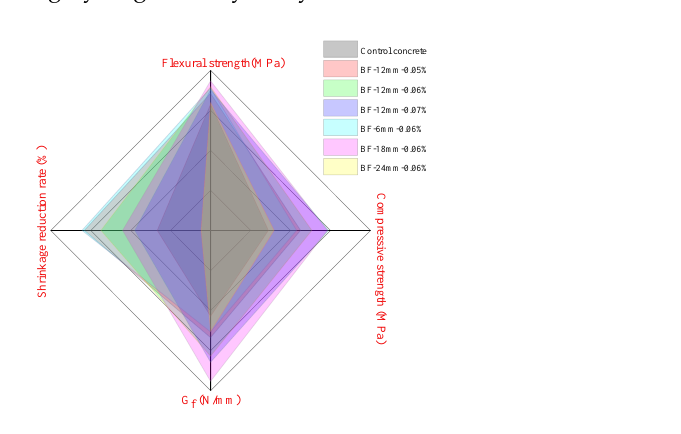
Figure 20. The approaching degree of concrete.